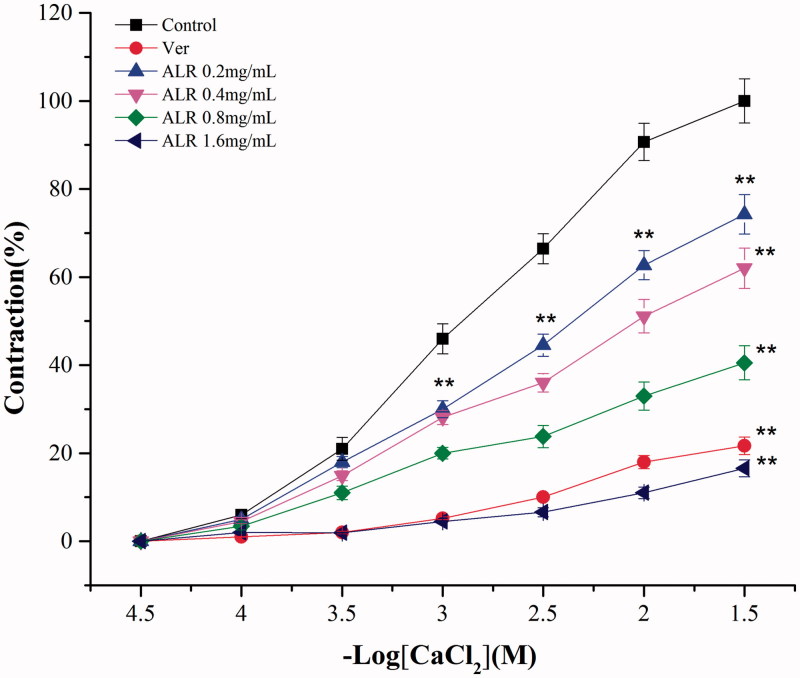
Concentration–response curves of CaCl2 on rat-isolated jejunum in the absence and in the presence of ALR and verapamil (n = 6). Compared with vehicle control group: **p < 0.01. ANOVA followed by Dunnett’s multiple comparison test.